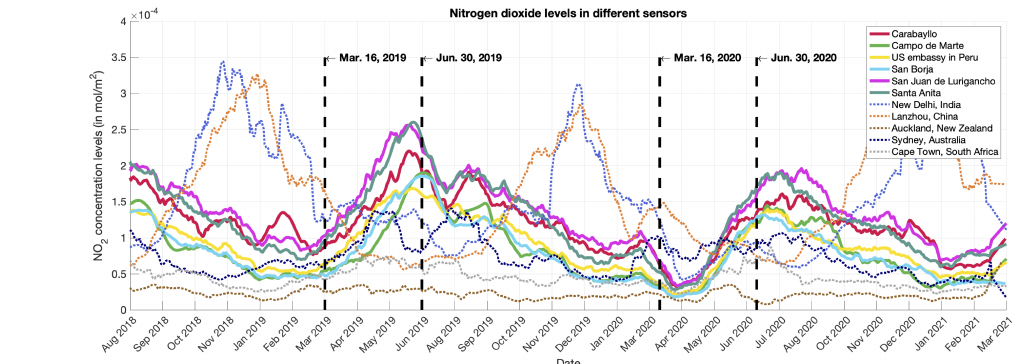
Figure 6. Historic nitrogen dioxide pollution levels for the six locations of the sensors of SENAMHI selected (see Section 2.2), from August 2018 to March 2021. We also include New Delhi (India), Lanzhou (China), Auckland (New Zealand), Sydney (Australia), and Cape Town (South Africa) as